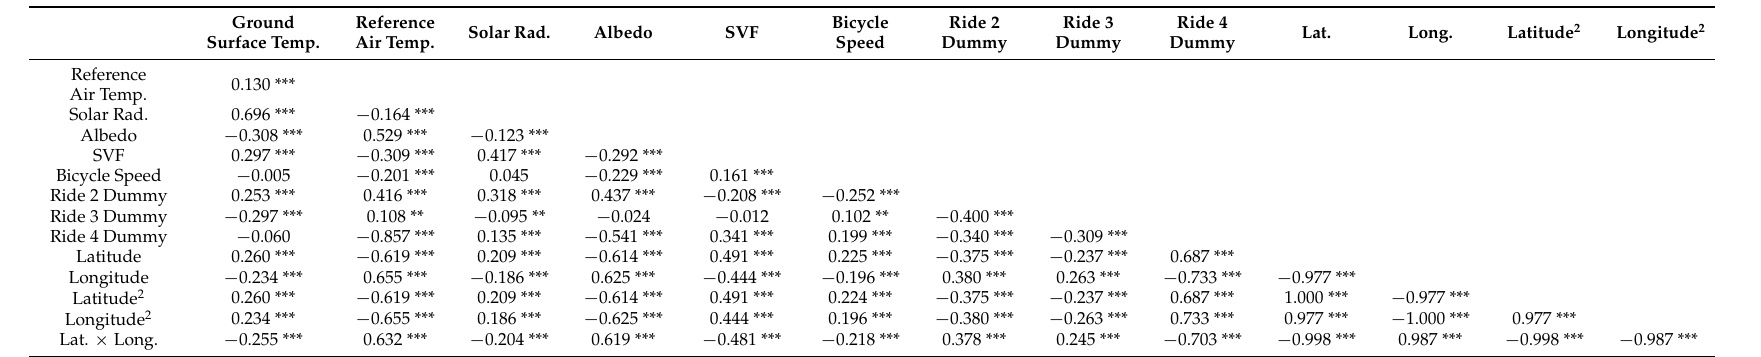
Table 2. Bivariate correlations among physical characteristics and ground surface